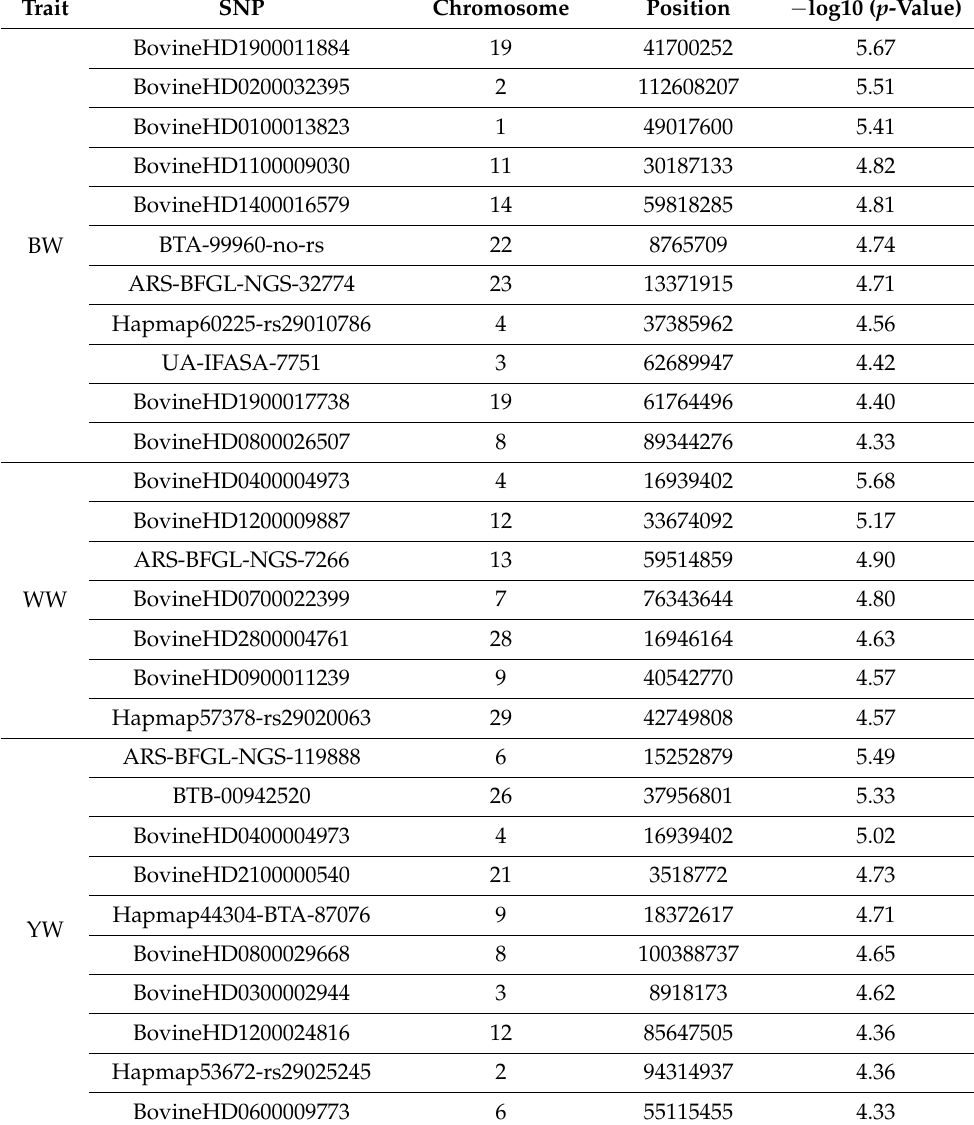
Table 4. Results of significant dominance SNP effects from genome wide association study of growth